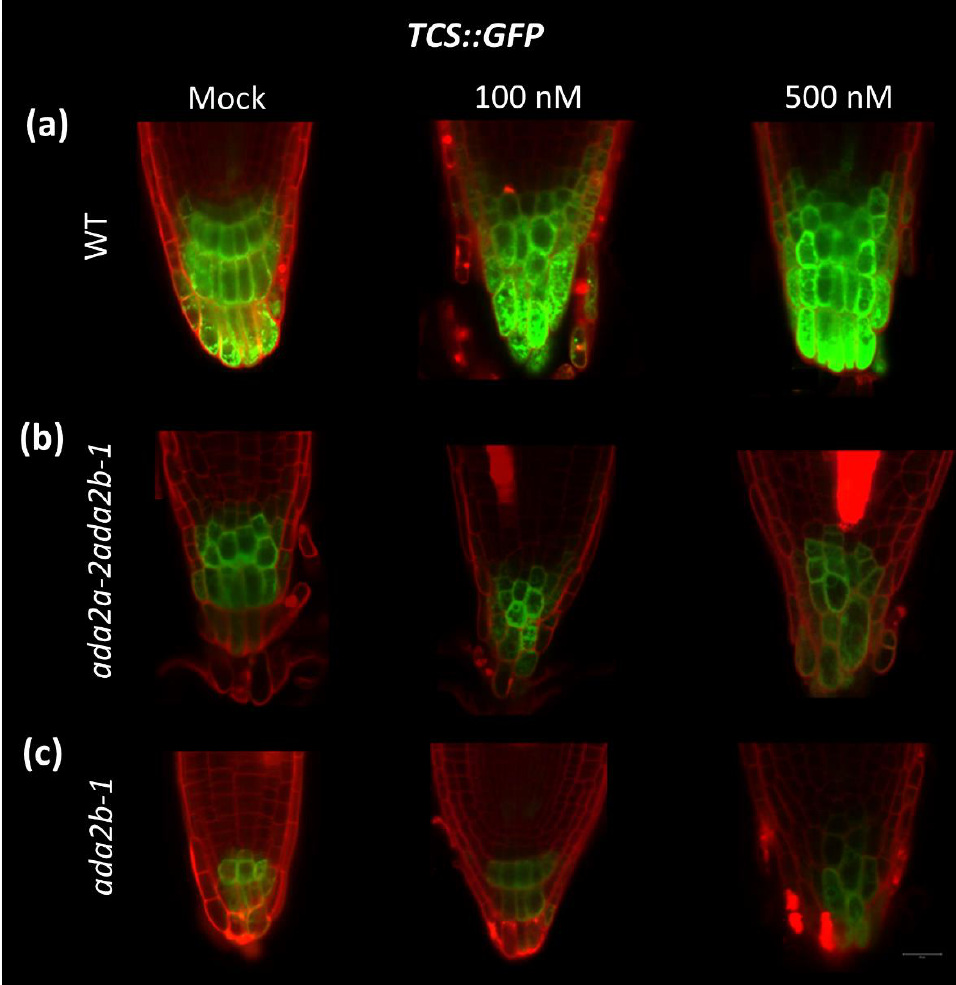
Figure 6. The role of ADA2b and ADA2a in auxin-induced cytokinin signaling during early root growth in Arabidopsis thaliana . The expression of reporter gene TCS :: GFP in roots of ( a ) wild type (WT), ( b ) ada2a-2ada2b-1 double mutant, and ( c ) ada2b-1 mutant treated with 100 or 500 nM exogenous auxin IAA for 24 h or grown in control media (mock). Roots stained with iodide propidium (PI: 10 μg /mL) and observed on confocal fluorescence microscopy. The scale bar represents 20 μm.